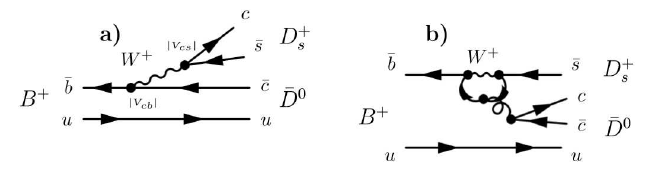
Figure 1. Quark diagrams of the process B + → ¯ D 0( ∗ ) D ( ∗ )